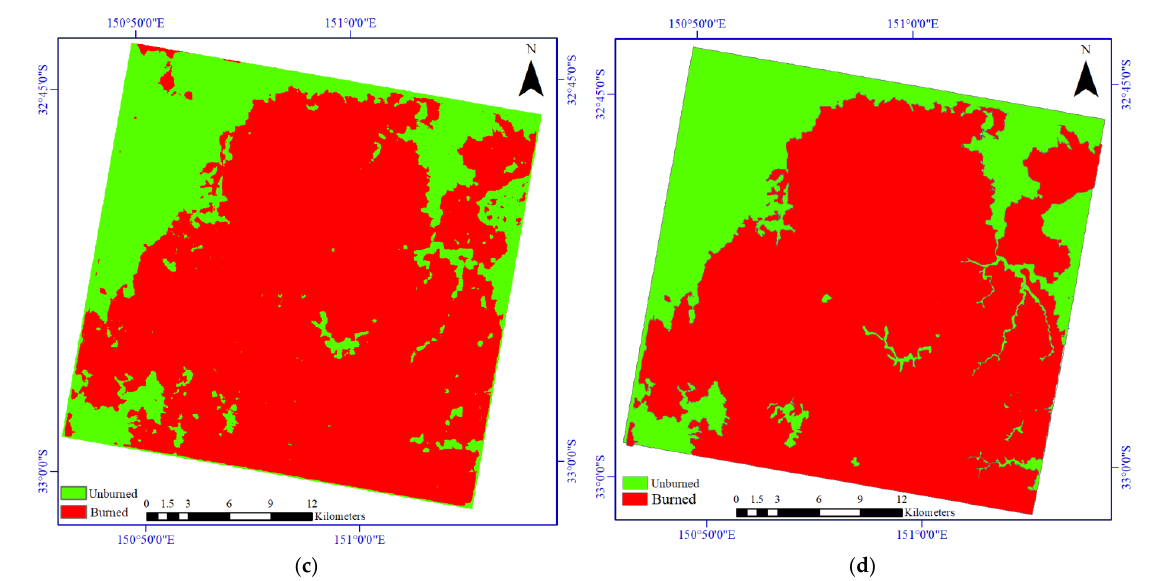
Figure 8. Visual comparisons of the results for the burned area mapping based on pre-event Sentinel-2 and post-event PRISMA imagery for the first study area. ( a ) Deep Siamese network. ( b ) Using the CNN method proposed in [42]. ( c ) Using the DSMNN-Net. ( d ) Ground truth map. Table 4. Accuracy assessment for the burned area mapping for the first study area. S#1, pre/post-event Sentinel-2 imagery; S#2, pre-event Sentinel-2 imagery and post-event PRISMA